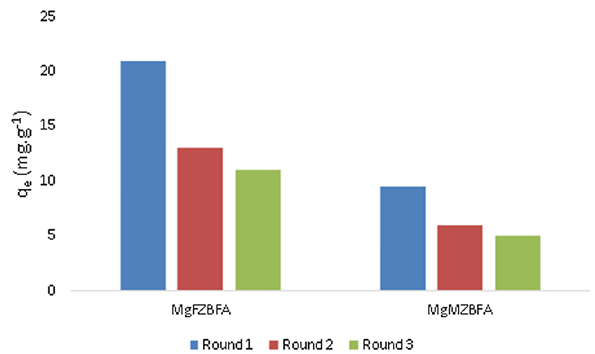
Fig. 19 Regeneration (from PNAN sorption) and reuse of MgFZBFA and MgMZBFA